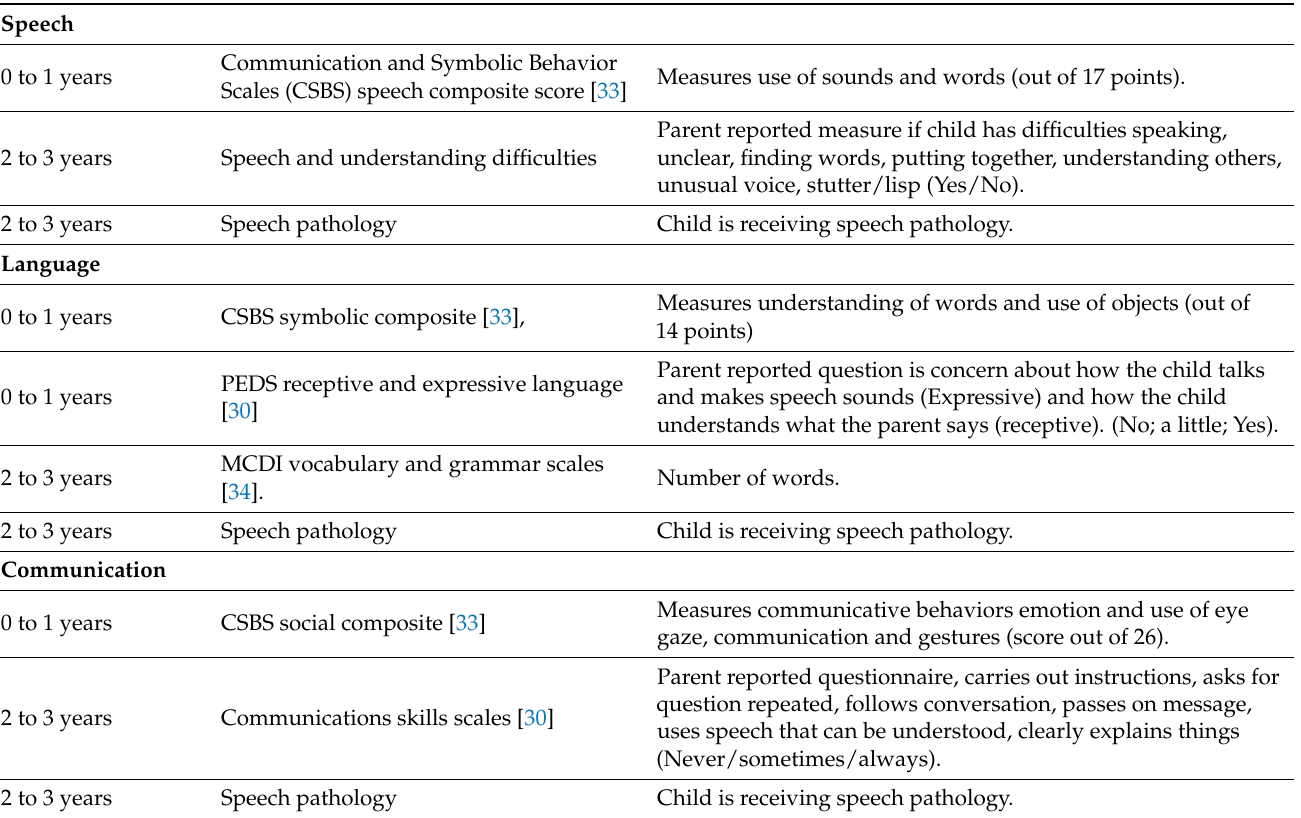
Table A1. Definitions of